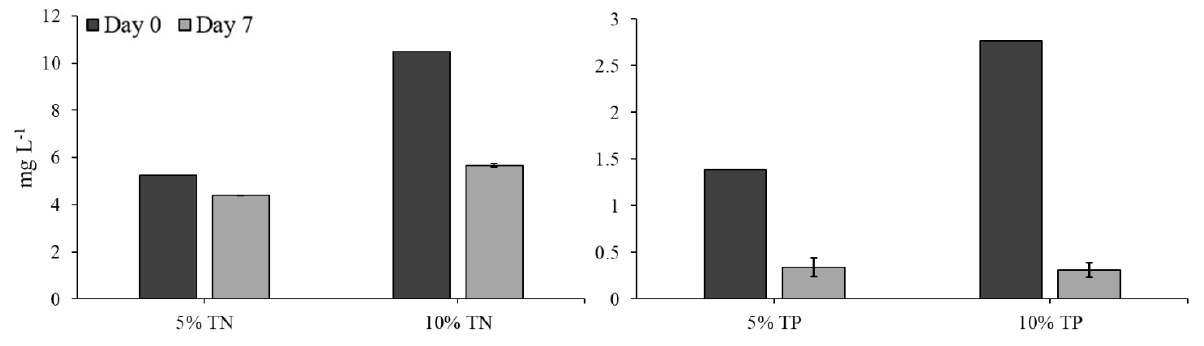
Figure 4. Comparison of the total nitrogen (TN) and the total phosphate (TP) concentration (mg L − 1 ) on day 0 and day 7 of L. minor growth, when cultivated on 5% or 10% AD-DPW (mean ± SE). For all treatments, the total nitrogen or total phosphate concentration was significantly lower on day 7 than on day 0 ( p < 0.05).